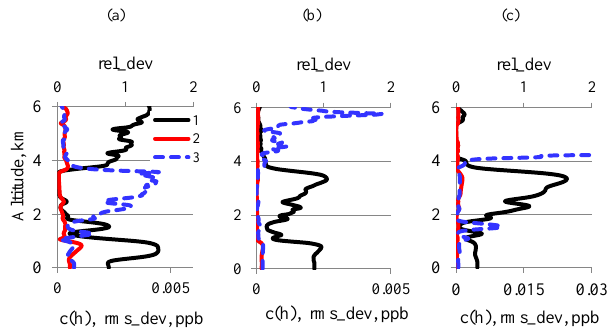
Figure 8. Variations of PVC profiles, c k (h) , retrieved with 20% uncertainties in the aerosol lidar ratios; data of München lidar, EARLI09 intercomparison campaign, 14:30–15:30UTC, 25 May 2009, Leipzig, Germany are used; (a) fine, (b) coarse spheri- cal, (c) coarse non-spherical modes; 1 – average value, 2 – rms- deviation, 3 – relative deviation.